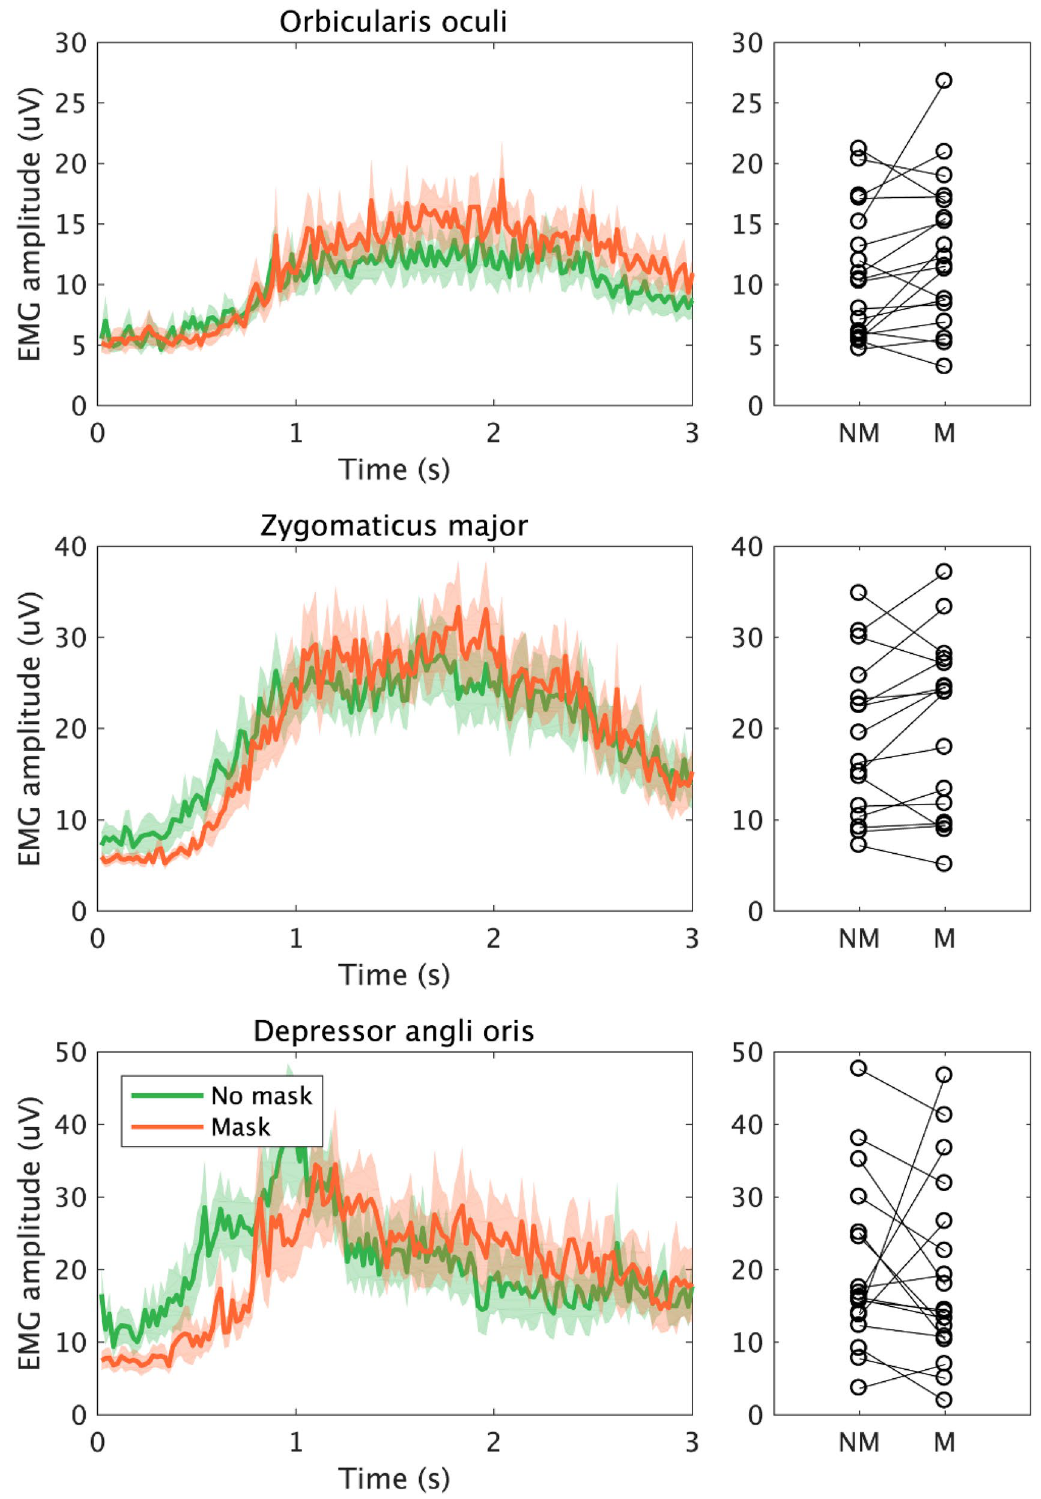
Figure 3. EMG signal measured over orbicularis oculi, zygomaticus major, and depressor anguli oris, during the smiling task (3 s). Plots and colours are the same as in Fig. 2. There were no significant changes in the muscle activity of the three muscles in the smiling